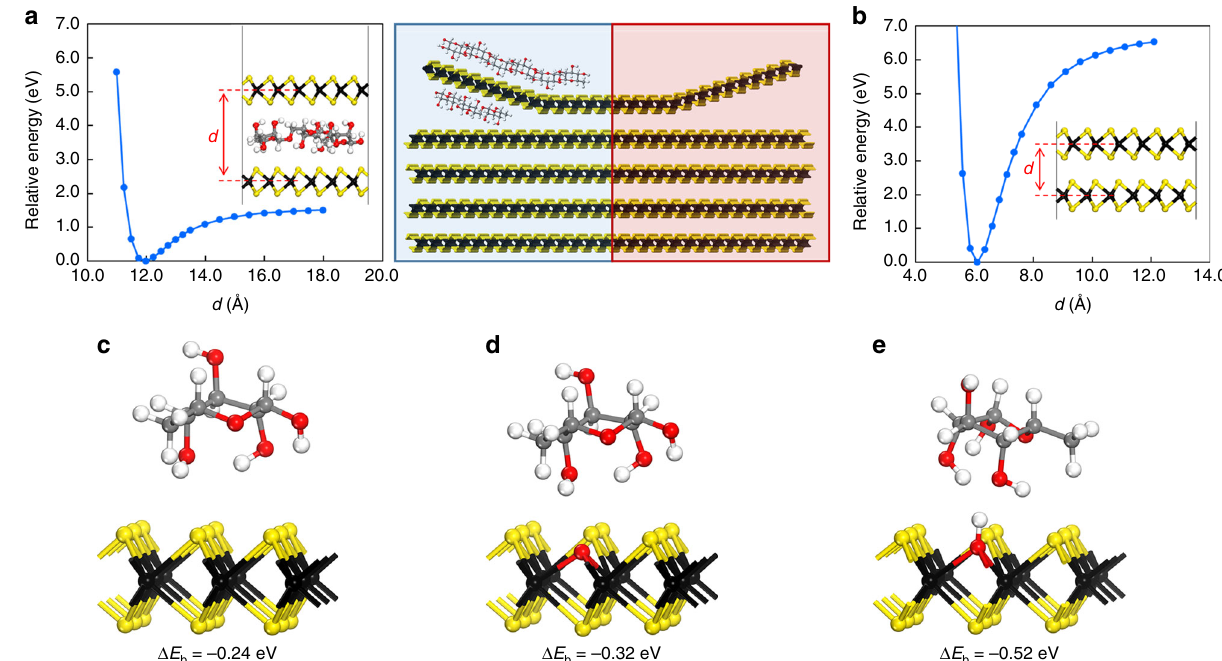
Fig. 4 DFT simulation for the interactions between dextran and TMD. Potential energy of interaction between two parallel monolayers of WS 2 a with and b without dextran. The central image illustrates an exfoliation process in two cases. Binding energy of the hydrophilic hydroxyl groups of dextran with c pure WS 2 , d oxygen-defective WS 2 , and e hydroxyl-defective WS of MW 1000 (dex1000) was employed in an exfoliation process (Supplementary Fig. 8a), the color of the obtained solution of exfoliated WS 2 (dex1000-WS 2 ) became lighter and more transparent than the solution of WS 2 nanosheets exfoliated by dextran of MW 40,000 (dex-WS 2 ), indicating that the amount of